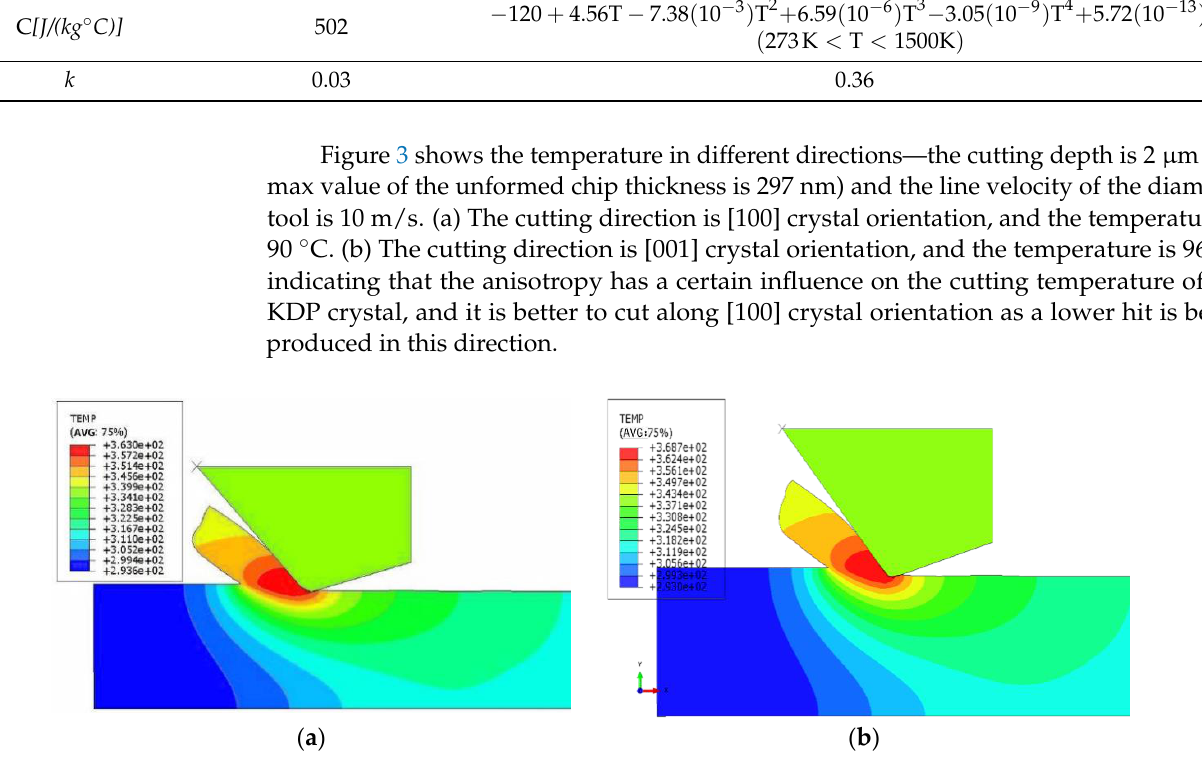
Figure 3. Temperature distribution along different crystal orientations: ( a ) [100] crystal orientation, ( b ) [001] crystal orientation.